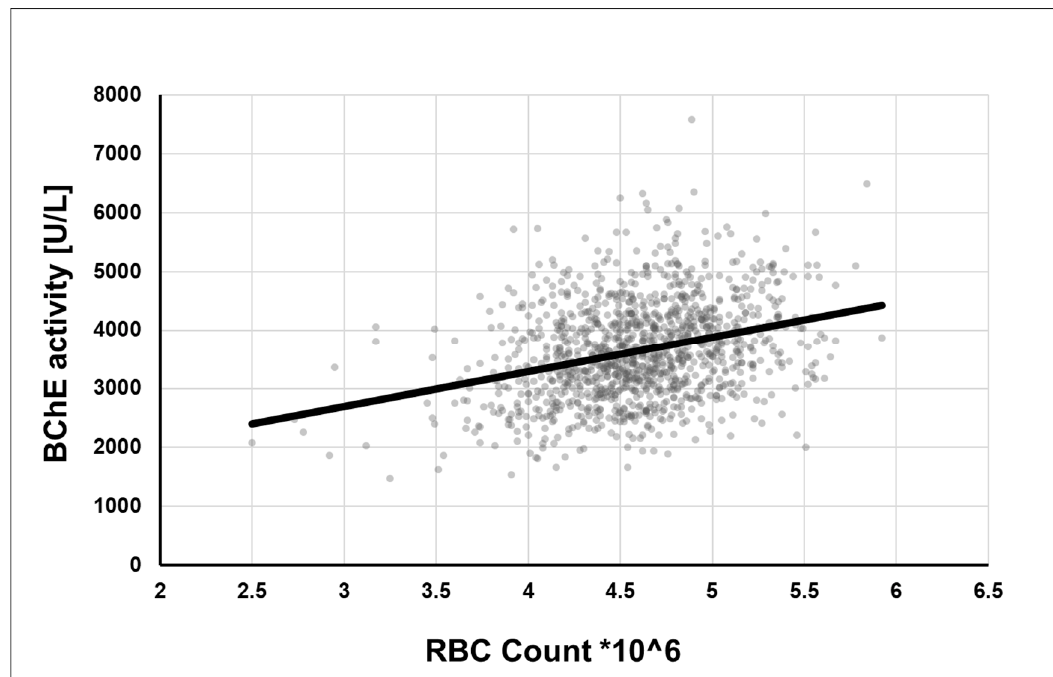
Figure 3. Interrelationship of peripheral serum butyrylcholinesterase (BChE) activity and red blood cell (RBC) count. The plasma BChE level shows a positive correlation with RBC count in a large cohort of 1191 individuals. The enzyme activity of a single person is represented by a grey dot. BChE activity was measured by Ellman’s reaction, as described earlier [156].